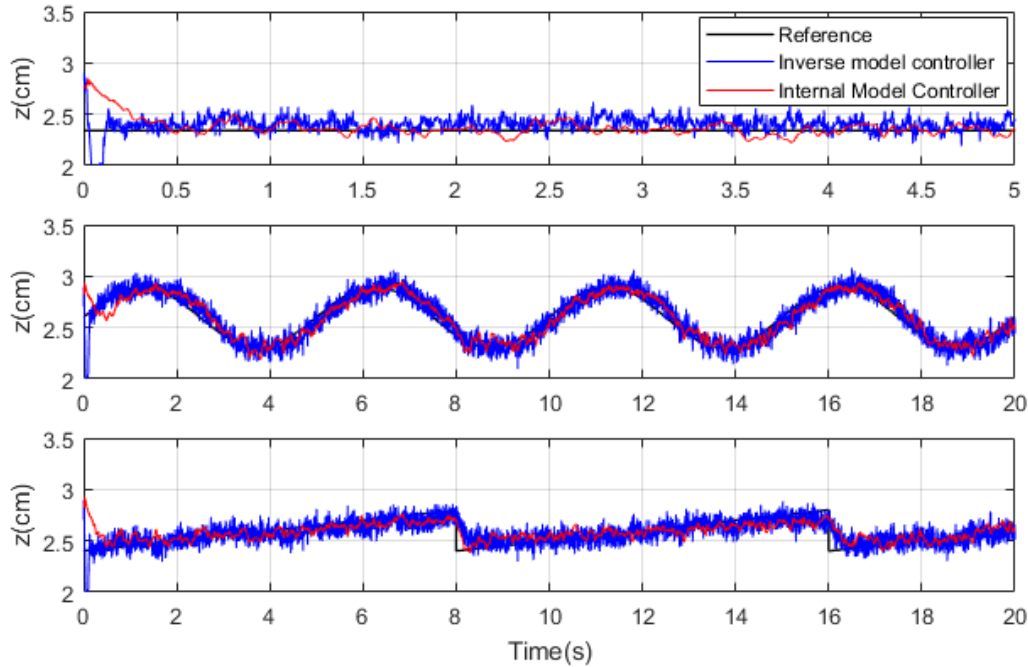
Figure 22. Comparison of system responses with the inverse model with adaptive block and internal